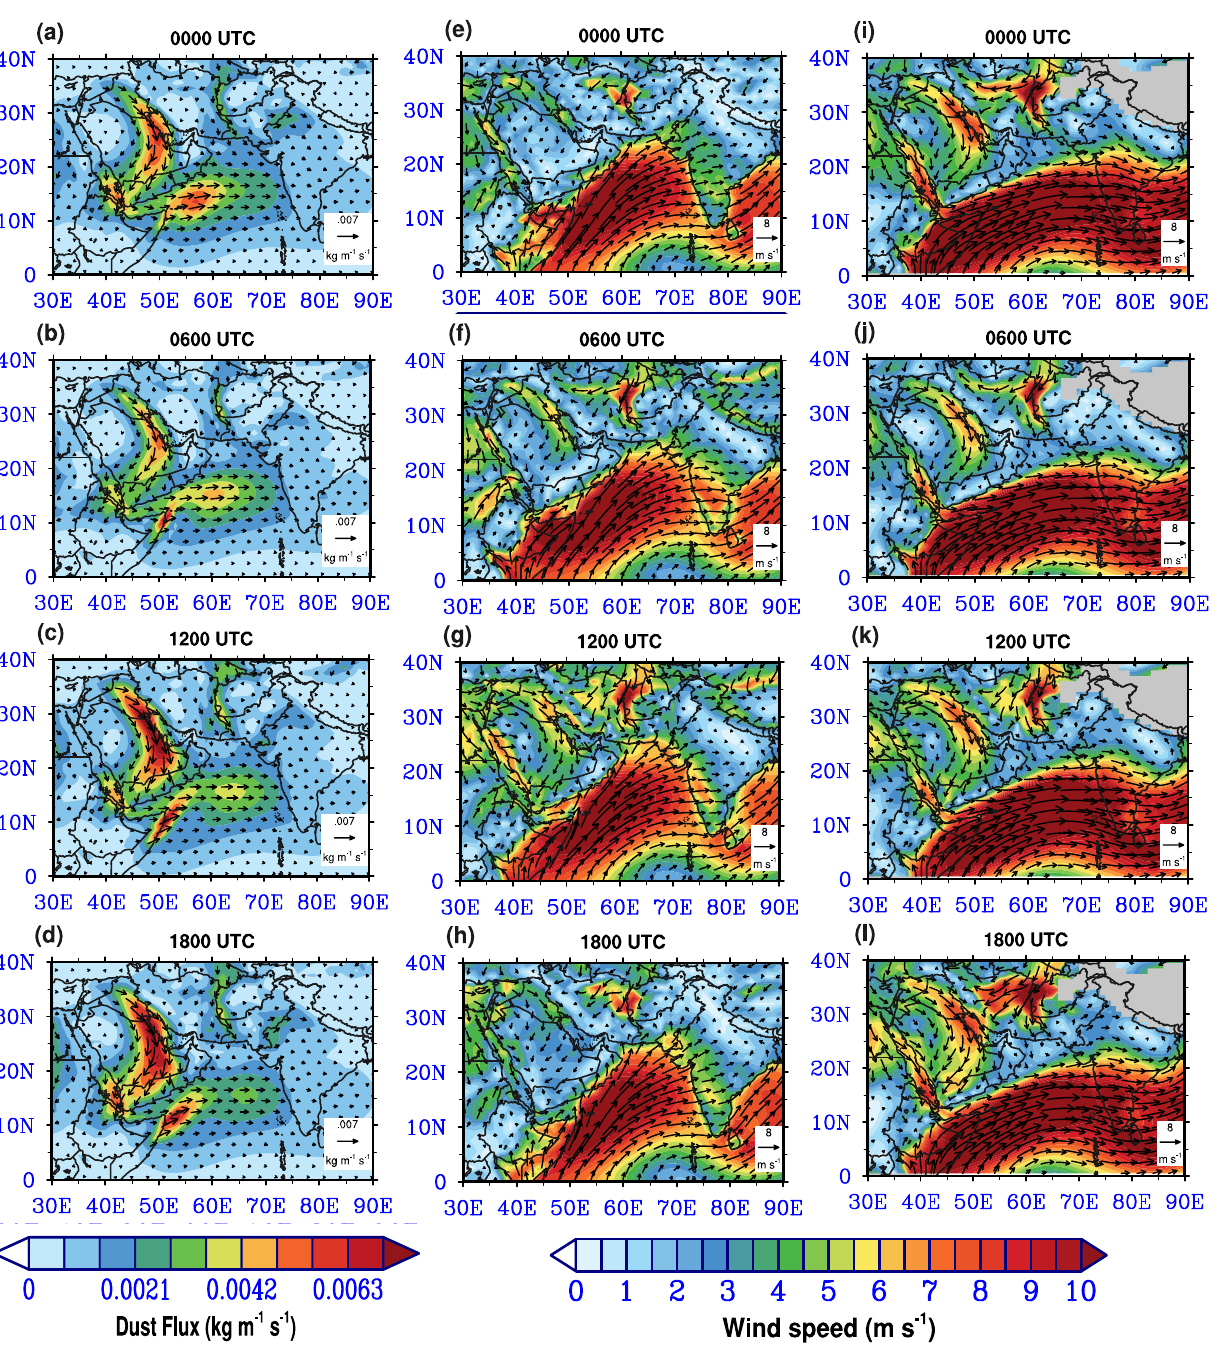
Fig. 9 Diurnal distribution of dust transport and winds. Spatial patterns of 6 hourly summer season climatology of column integrated horizontal dust mass fl ux (shaded) and vectors ( a – d ), 10 m winds ( e – h ), and low-level winds averaged between 925 and 700 hPa levels ( i – l ) for the period 2007 – 2016. All the plots are based on the MERRA-2 reanalysis